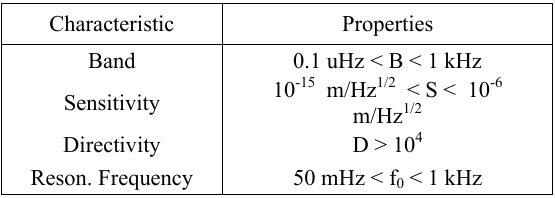
Table 1. UNISA Folded Pendulum Main Characteristics